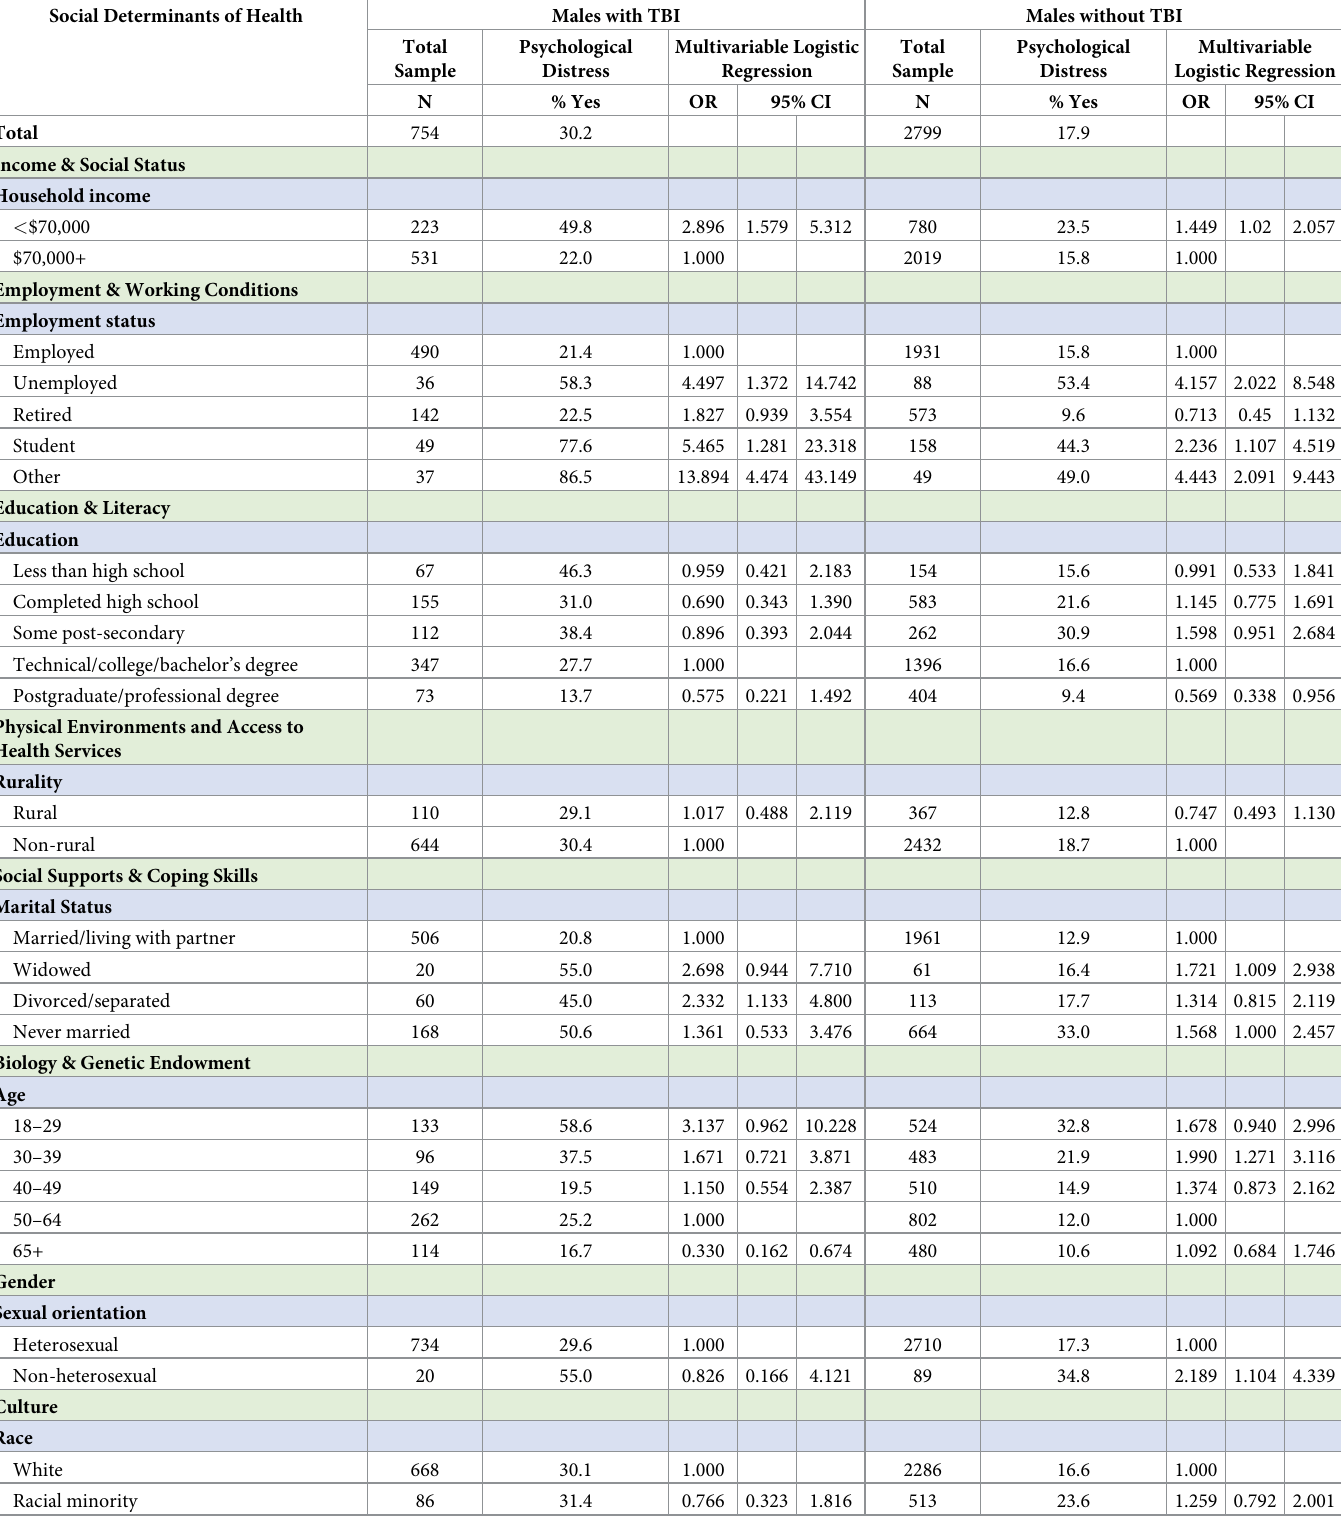
Table 2. Prevalence of psychological distress and multivariable logistic regression analyses of SDoH and psychological distress among males with and without